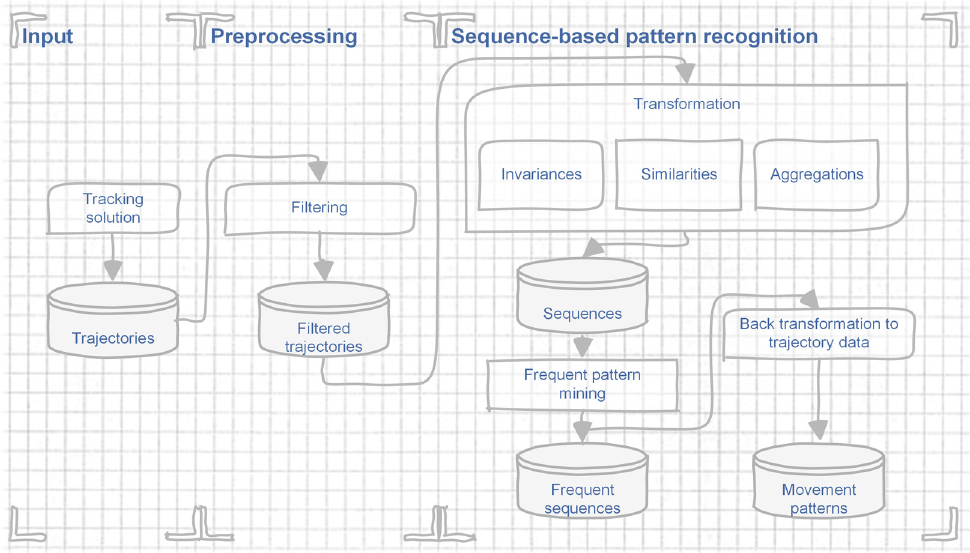
Figure 3. Scheme of our pattern recognition approach.